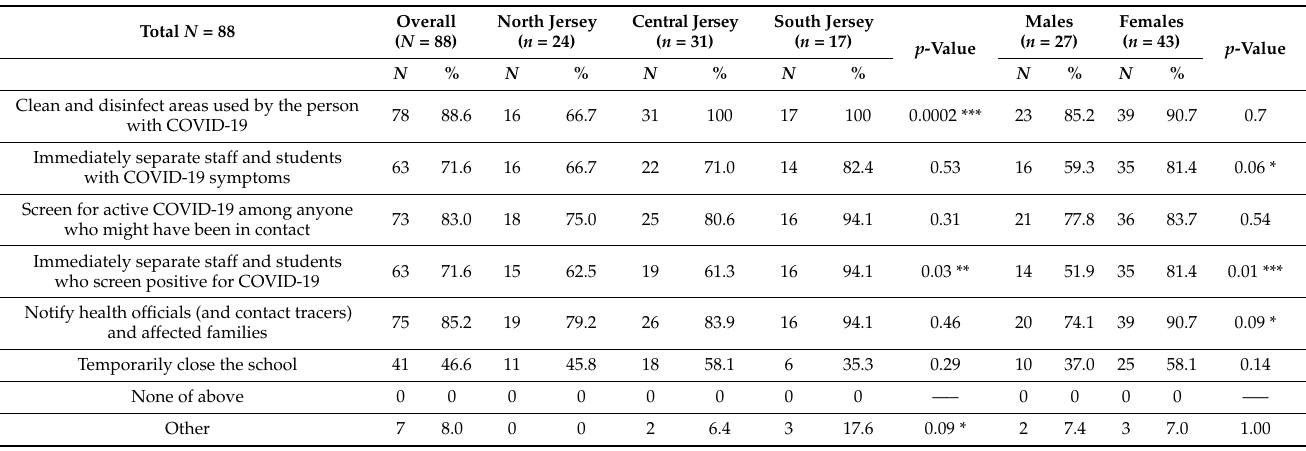
Table 5. Which of the following do you feel would be an appropriate protocol for the school? Stratified by regions of NJ and reported gender. Note: p -values were determined by Fisher’s exact